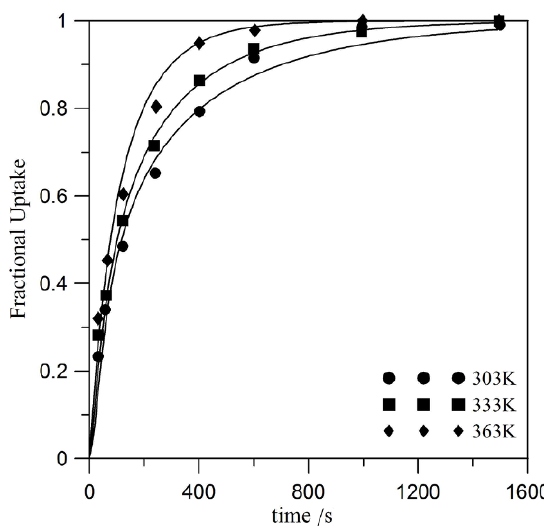
Figure 3. Comparison of the experimental kinetic isotherms for the C H /Norit AC adsorption measured by Qiao and Hu 2 6 [14] with the theoretical isotherms (solid lines) calculated from Eq. 10 by accepting the values of parameters collected in Table 1. The values of parameters a and b as well as error function corresponding to quality of fitting are collected in the last three columns of Table 1.